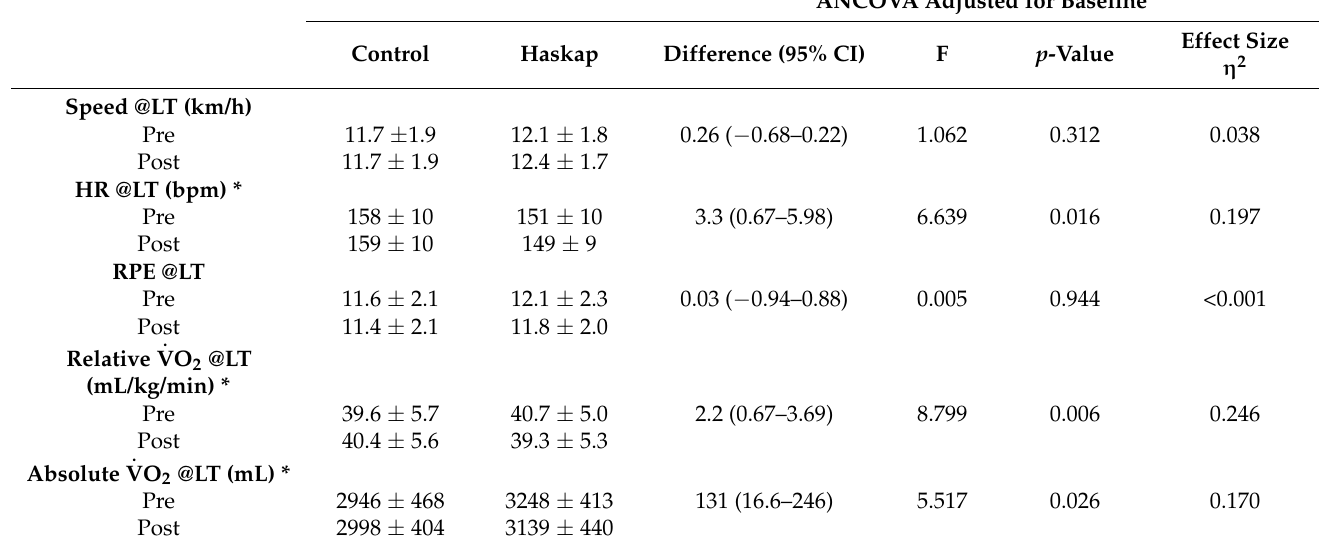
Table 2. Data from the submaximal test for lactate threshold (LT) parameters before and after the intervention of Haskap or placebo